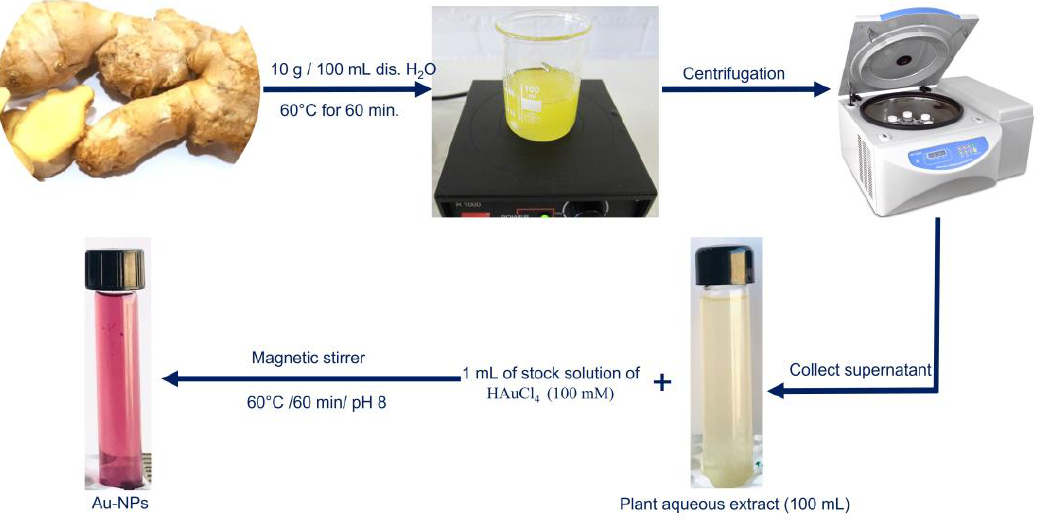
Figure 1. Scheme for green synthesis of AuNPs using the aqueous extract of Z. officinale rhizome.